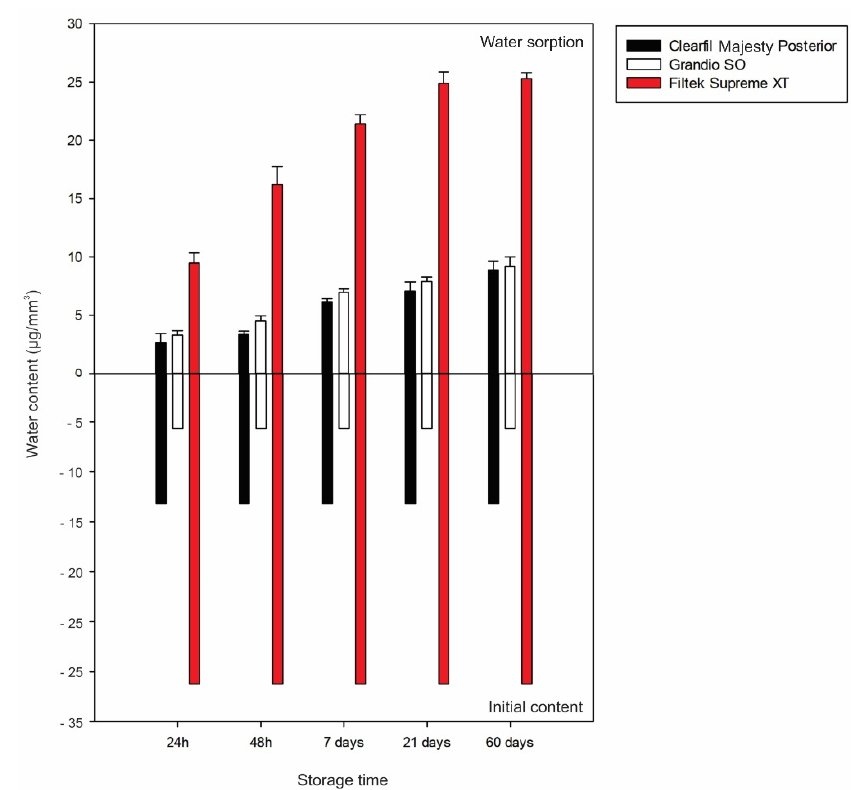
Figure 3. Bar charts illustrating the amount of water sorption (in µ g/mm 3 ) of each material according to storage times. The water sorption (upper part) was estimated by subtracting the final water content from the initial (lower part) measured for non-stored